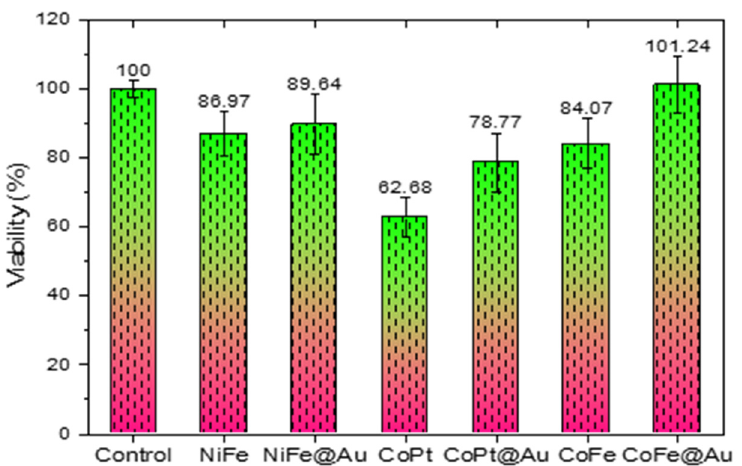
Figure 6. Cell viability of bare NiFe, CoPt, CoFe, and gold-coated (@Au) nanowires for 0.2 mg/mL